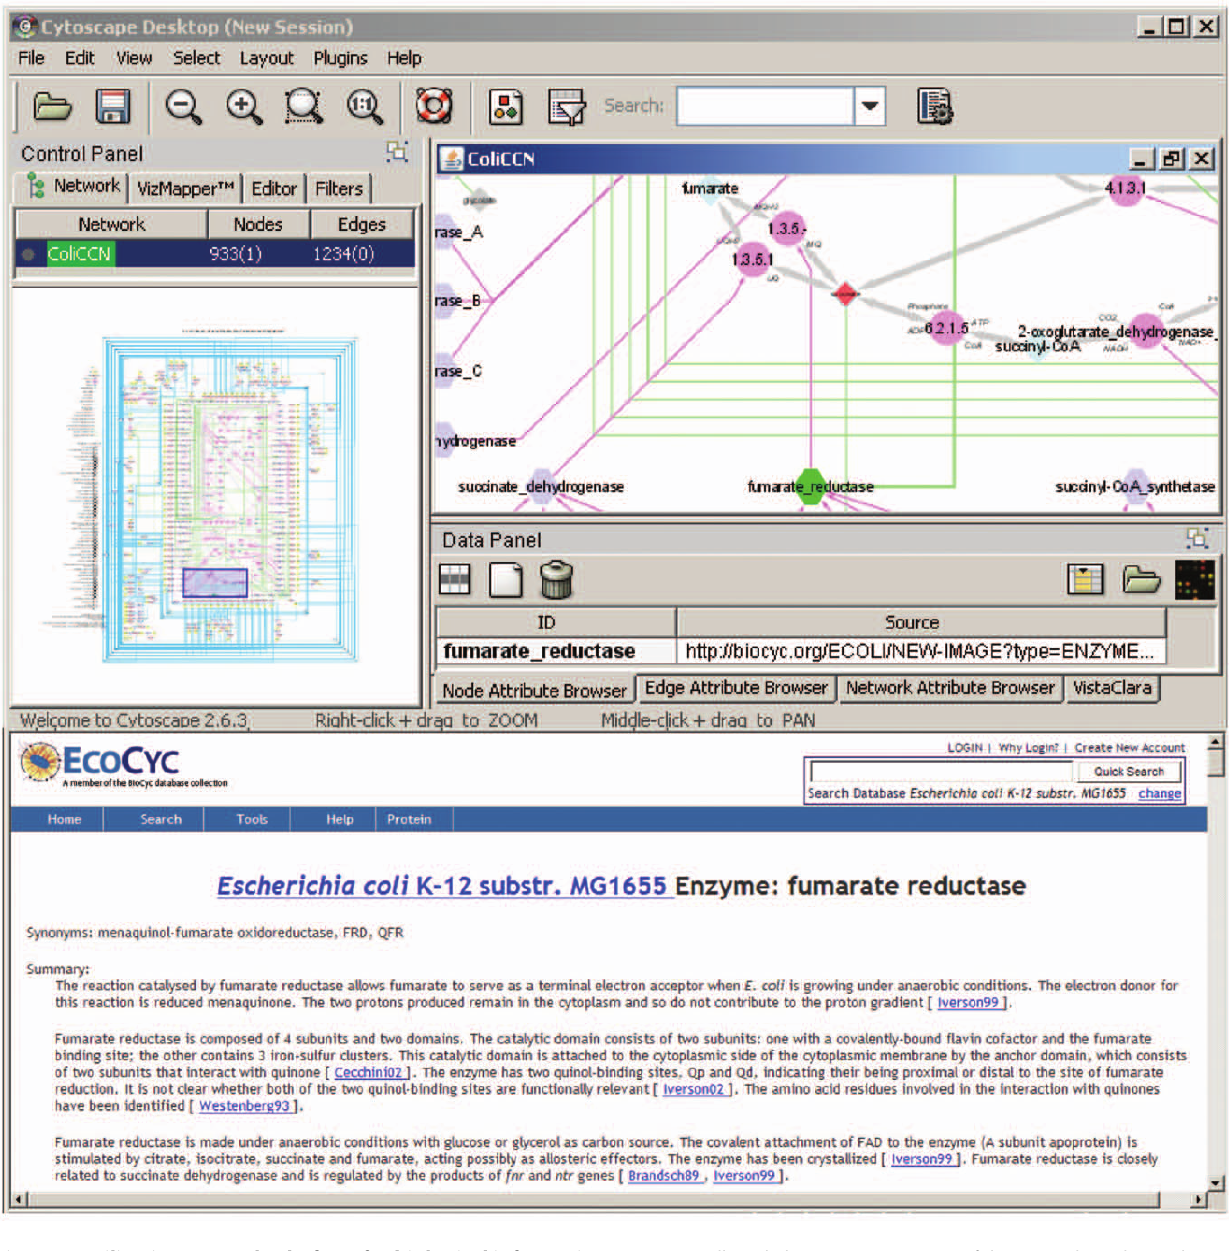
Figure 3. Utilization as a web-platform for biological information. Cytoscape allows linking any component of the network (node or edge) to a webpage. This functionality was used to link all the nodes and edges of the graph to relevant information in the databases from which the biological network was generated. For example, one can select the fumarate reductase activity (highlighted in green in the cytoscape main visualization window) and click on the associated link (‘‘Source’’) to access the corresponding information page in Ecocyc (bottom window).